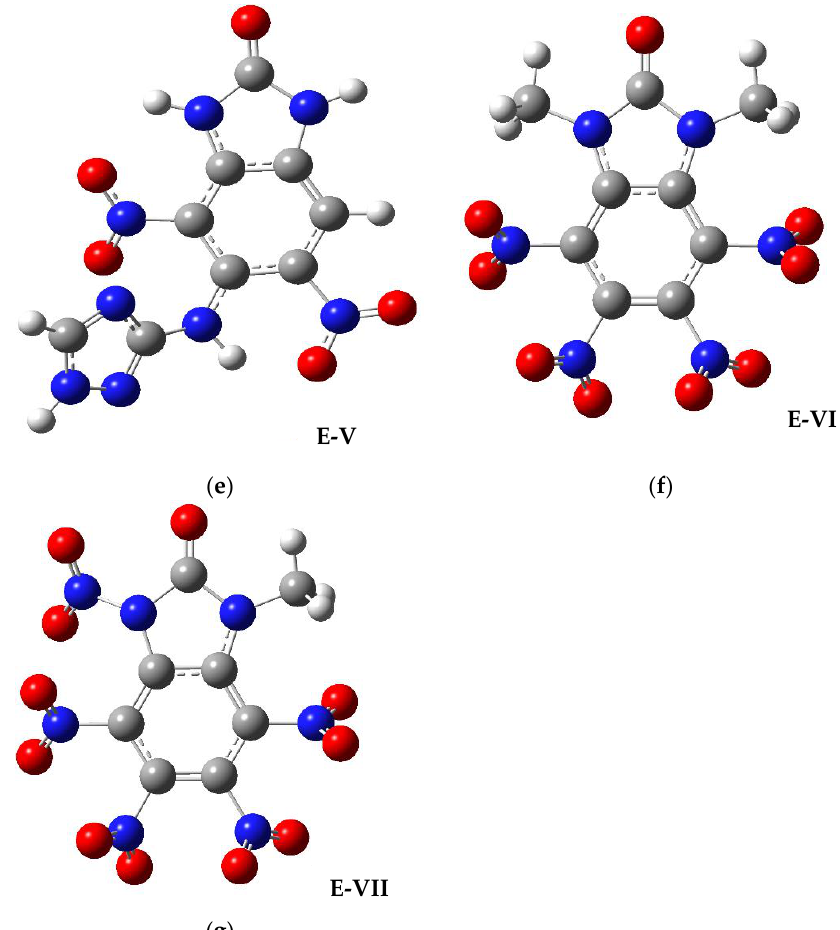
Figure 1. The structures of the molecules under investigation: ( a )—initial molecule (E-I), ( b )—the initial molecule with a methyl substituent joined to the imidazole ring (E-II), ( c )—the initial molecule with two additional nitro groups joined to the imidazole ring (E-III), ( d )—the initial molecule with a C 2 H 3 N 4 substituent to the benzene ring (E-IV), ( e )—the initial molecule with a C 2 H 3 N 4 (triazolyl amino) ring and 7-H to the benzene ring (E-V), ( f )—the initial molecule with two methyl groups joined to the imidazole ring (E-VI), ( g )—the initial molecule with nitro and methyl substituents joined to the imidazole ring (E-VII). The abbreviation of the molecule names is used here and further in the text.